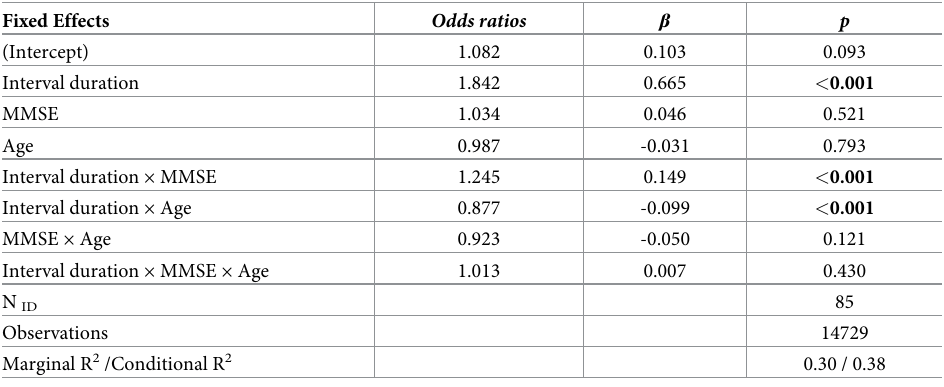
Table 2. Summary of the model outputs for the explicit timing